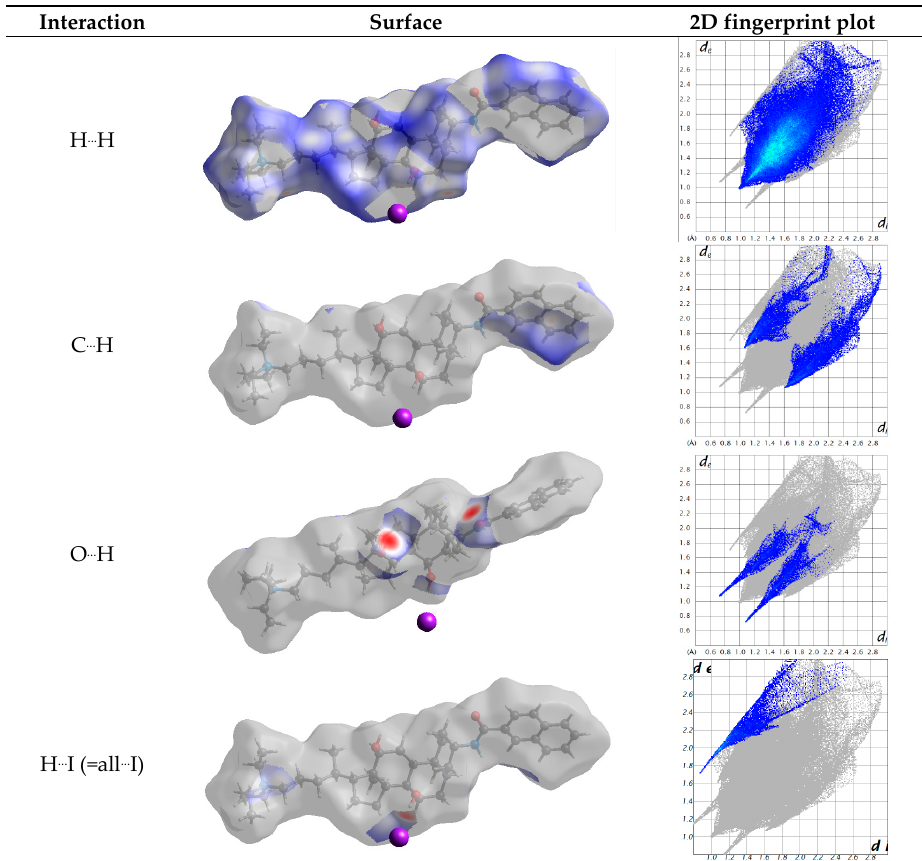
Figure 3. The Hirshfeld surface area with atoms of external fragments.